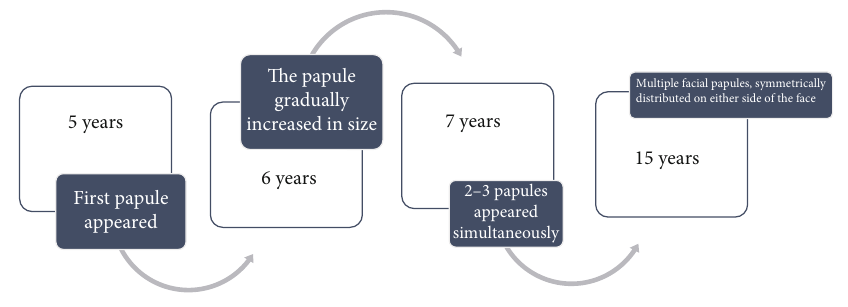
Figure 8: Timeline of the disease process. Table 2: Summarization of followed therapeutic regimen and